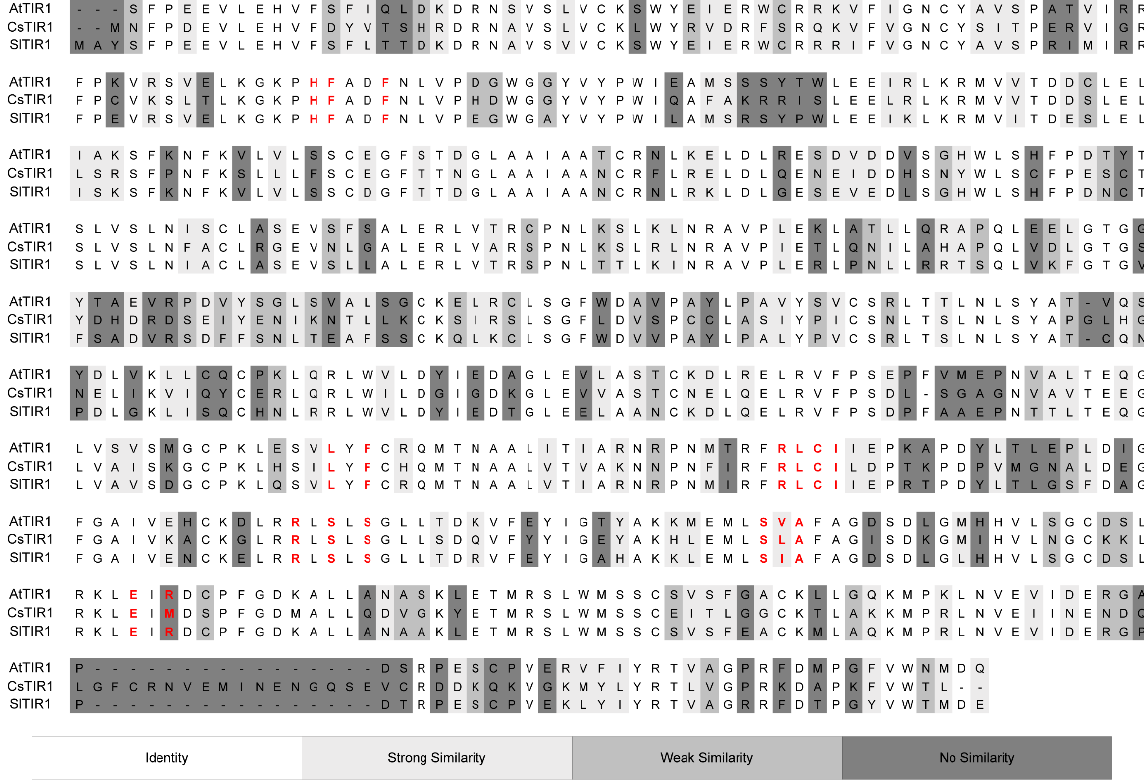
Figure 6. Sequence alignment between AtTIR1, CsTIR1 and SlTIR1. Amino acids are depicted as single-letter codes. Residues from the auxin-binding site are shown in red. The color of background indicates sequence similarity from white (identity) to dark grey (no similarity). See Table S1 in Supplementary Materials for detailed information about sequence similarity.